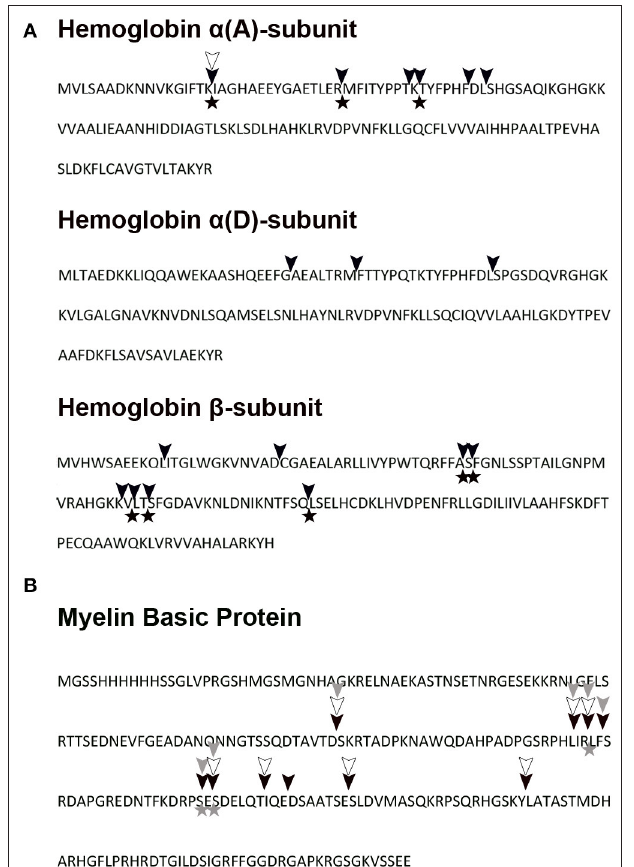
FIGURE 11 | Hemoglobin and myelin basic protein pepTrCB1 cleavage map. (A) Turkey hemoglobin and (B) recombinant human myelin basic protein were digested in vitro with pepTrCB forms at pH 5.5. The fragments were identified by mass spectrometry, and corresponding cleavage sites are indicated in hemoglobin and myelin basic protein sequences: cleavage by pepTrCB1.1 (black triangles), cleavage by pepTrCB1.4 (empty triangles), cleavage by pepTrCB1.6G/C (gray triangles). The cleavage map combines data from digests at three time points. The initial cleavage sites (after 5min of reaction) are marked with asterisks. Only unique fragments which were not detected at time zero are included.